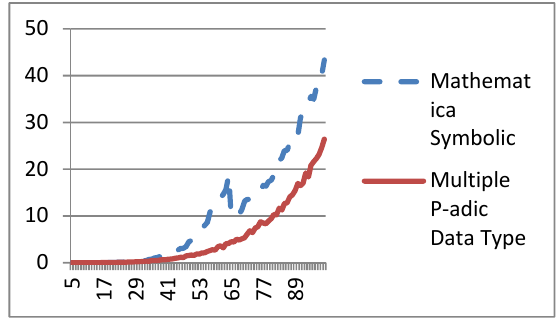
Figure 3. Vertical axis: calculation time (seconds) Horizontal axis: matrix size (N x N)